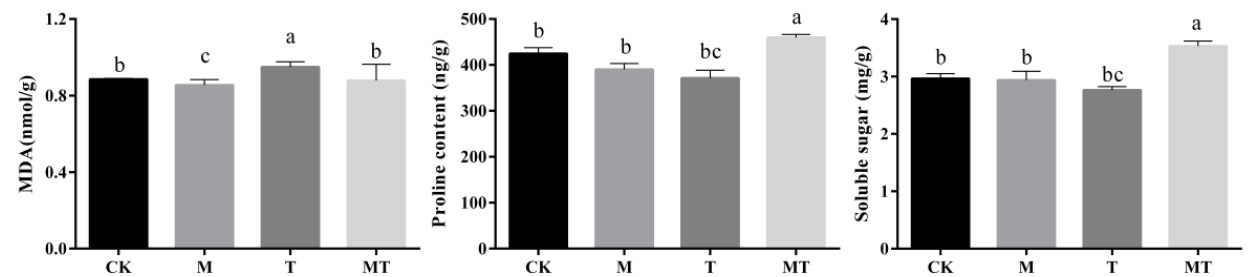
Figure 5. Influences of cold stress and melatonin treatments on the accumulations of osmoregulatory substances (MDA, proline and soluble sugar) in banana. Different letters above bars indicate a significant difference among samples at the p < 0.05 level. All the data are displayed as mean ± standard deviation for three replications. CK: control; M: melatonin treatment; T: low-temperature treatment; MT: combined melatonin and low-temperature treatment.